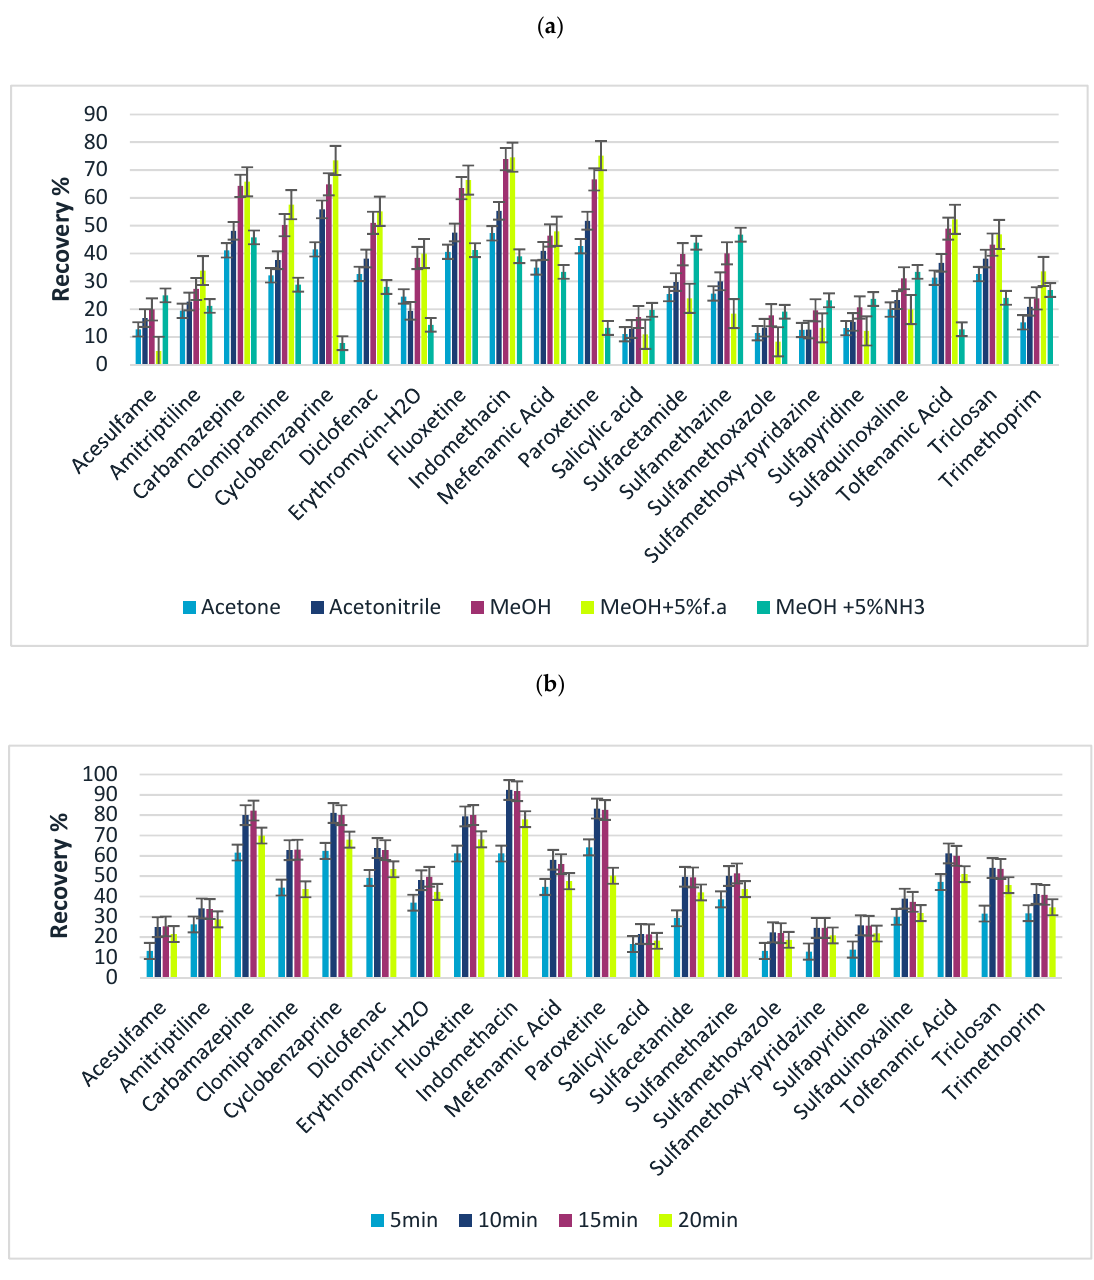
Figure 3. Effects on the desorption of target analytes ( a ) elution solvent and ( b ) elution time.